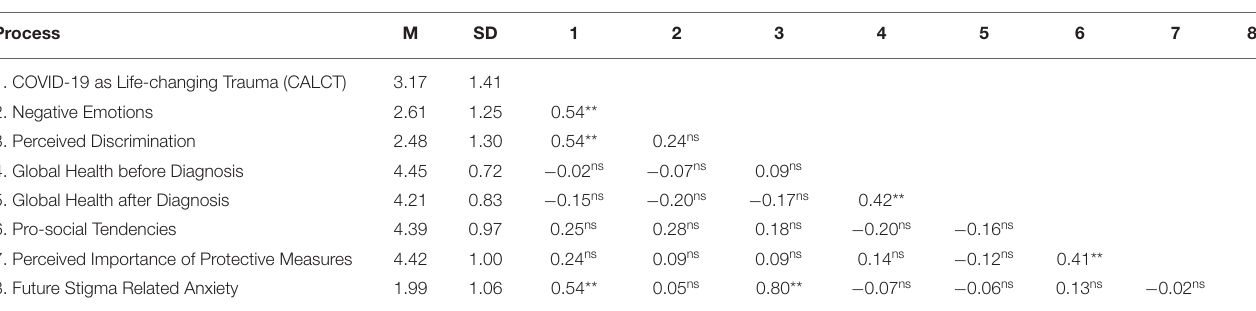
TABLE 2 | Descriptive statistics and correlations between the measured psychological processes.